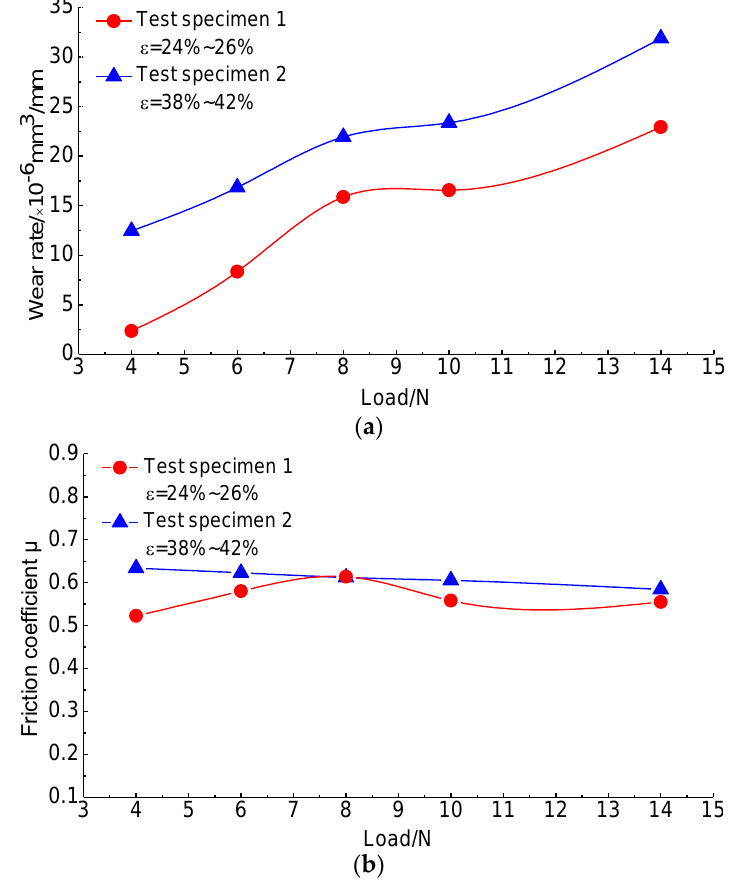
Figure 7. The variation curves of the wear rate and friction coefficient with the load: ( a ) relationship between the wear rate and the load of materials with different porosities; and ( b ) relationship between the friction coefficient and the load of materials with different porosities.